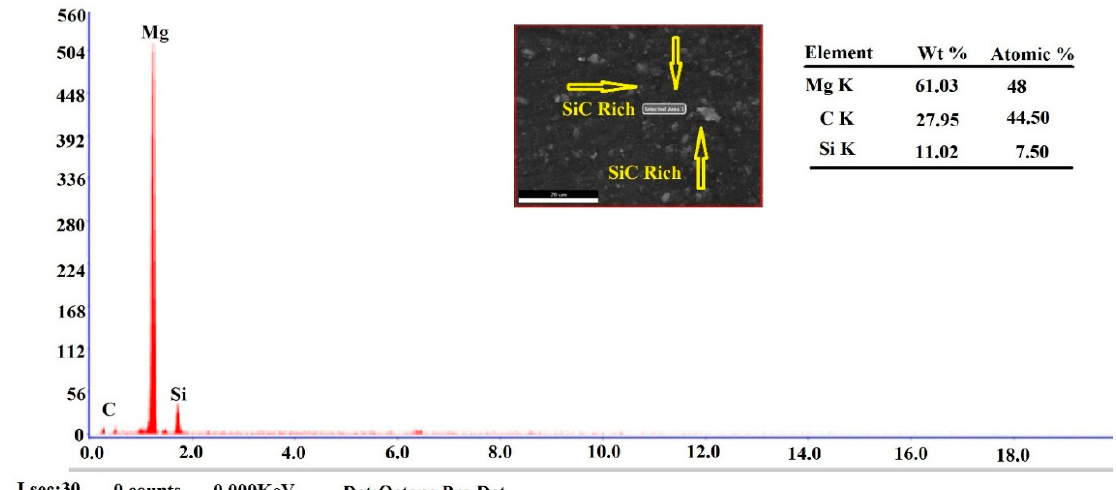
Figure 11. EDS peak points of reinforcement.